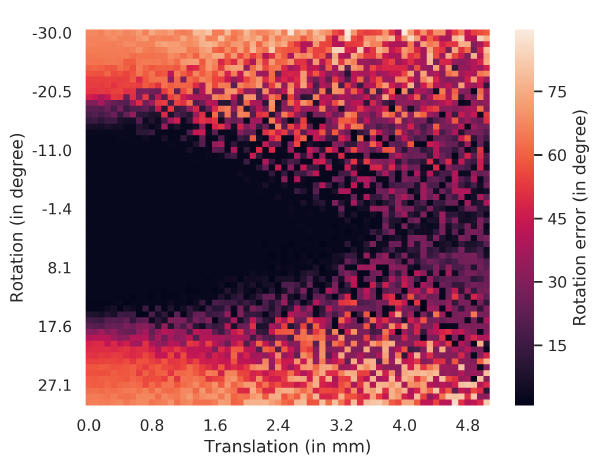
Figure 5. Convergence basin of ICP with respect to the initialization for pair of coin coming from the same die. In absciss axis, the norm of the translation varies from 0 to 5 mm. In ordinate axis, the rotation varies from -30 to 30 degrees. The dark part in this map represents the convergence basin of